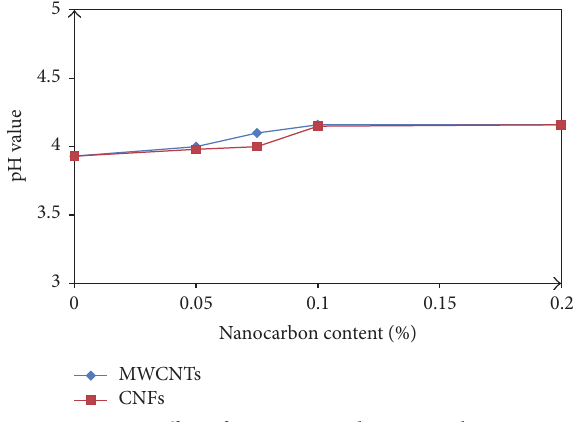
Figure 8: Effect of MWCNTs and CNFs on the pH.